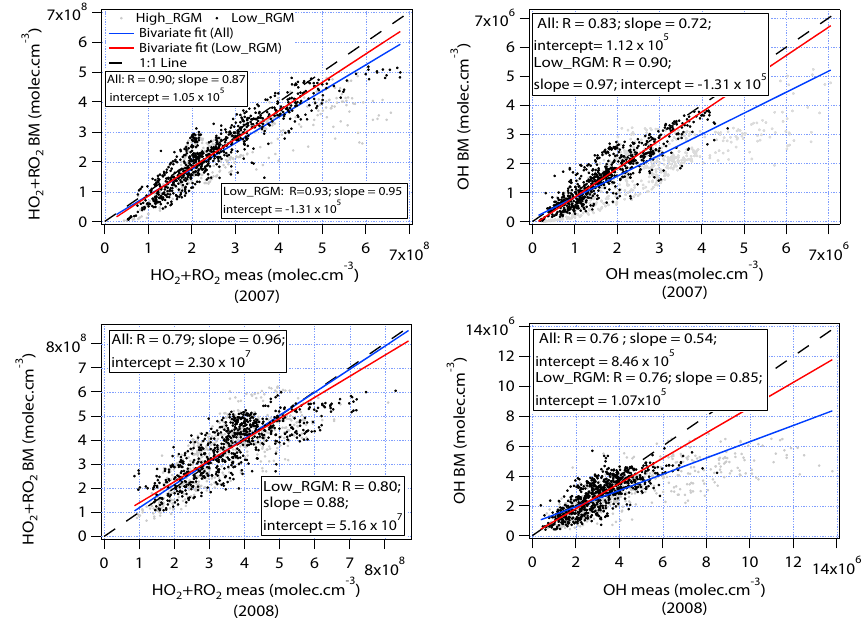
Fig. 8. The correlation plots of observed and predicted OH and HO 2 +RO 2 from the BM at low RGM conditions (black dots) and at high RGM conditions (gray dots) in 2007 and 2008. “All” represents the total data including low RGM and high RGM conditions. Equally weighted bivariate regressions are applied to all the data (blue line) and the data at low RGM conditions (red line), respectively. The relevant correlation coefficients, slopes, and intercepts are provided in the